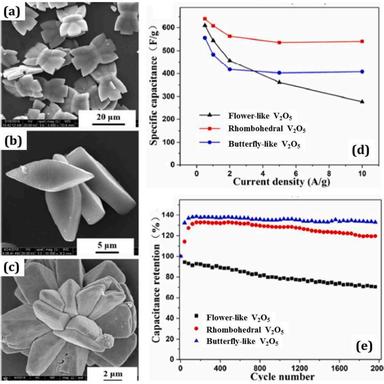
SEM micrographs of (a) butterfly-shaped, (b) rhombohedral, (e) flower-shaped V2O5. Electrochemical performance: (d) Csp vs CD graph; and (e) CV curves .. Reproduced from Ref.